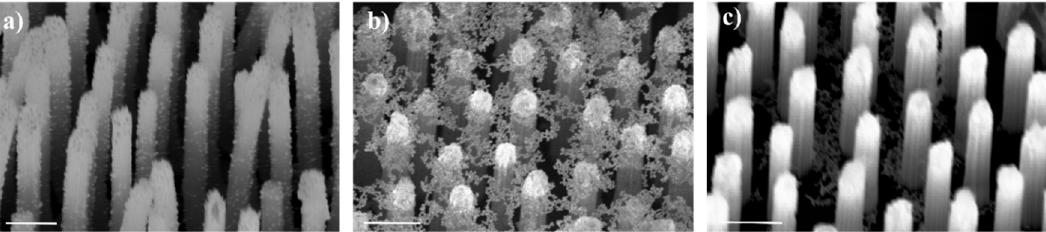
Figure 3. SEM images of three types of SERS substrates. ( a ) SEM image of S-SiNRs@AuNPs substrate; ( b ) SEM image of T-SiNRs@AuNPs substrate; ( c ) SEM image of B-SiNRs@AuNPs substrate. All of the SiNRs have a diameter of ~200 nm and a length of ~0.8–1.2 μ m for a single nanorod.